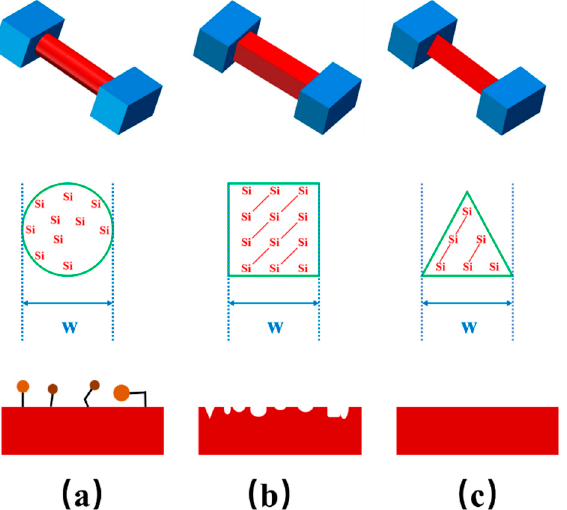
Figure 3. Three types of SiNWs-FET sensors and diagrammatic sketch of surface states and lattice quality with their cross-sections being ( a ) circle, ( b ) square, ( c ) triangle, respectively under the same feature size W.